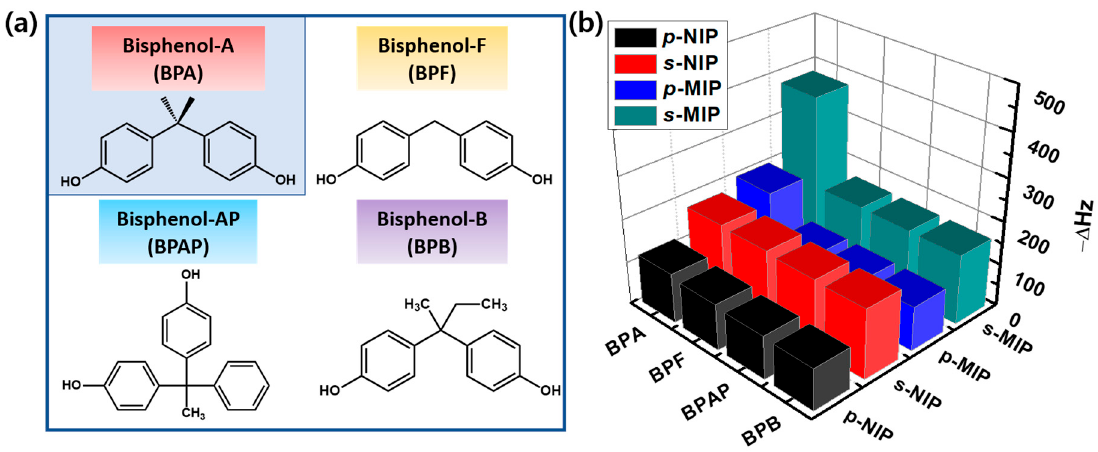
Figure 4. Comparative selectivity of the QCM sensors: ( a ) chemical structures of BPA, BPF, BPAP, and BPB and ( b ) the QCM sensing response ( − ∆ f ) of BPA, BPF, BPAP, and BPB solutions (225 nM) is shown for a 1-h measurement period on BPA-imprinted sensors ( p -MIP and s -MIP films) and non-imprinted sensors ( p -NIP and s -NIP films).